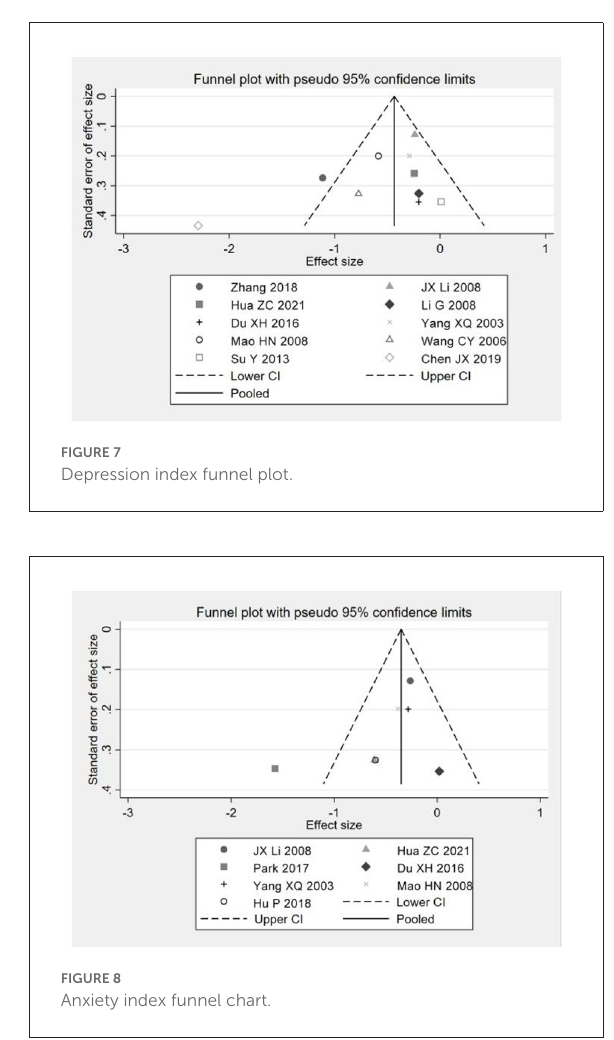
FIGURE6 Sensitivity analysis of anxiety indicators.